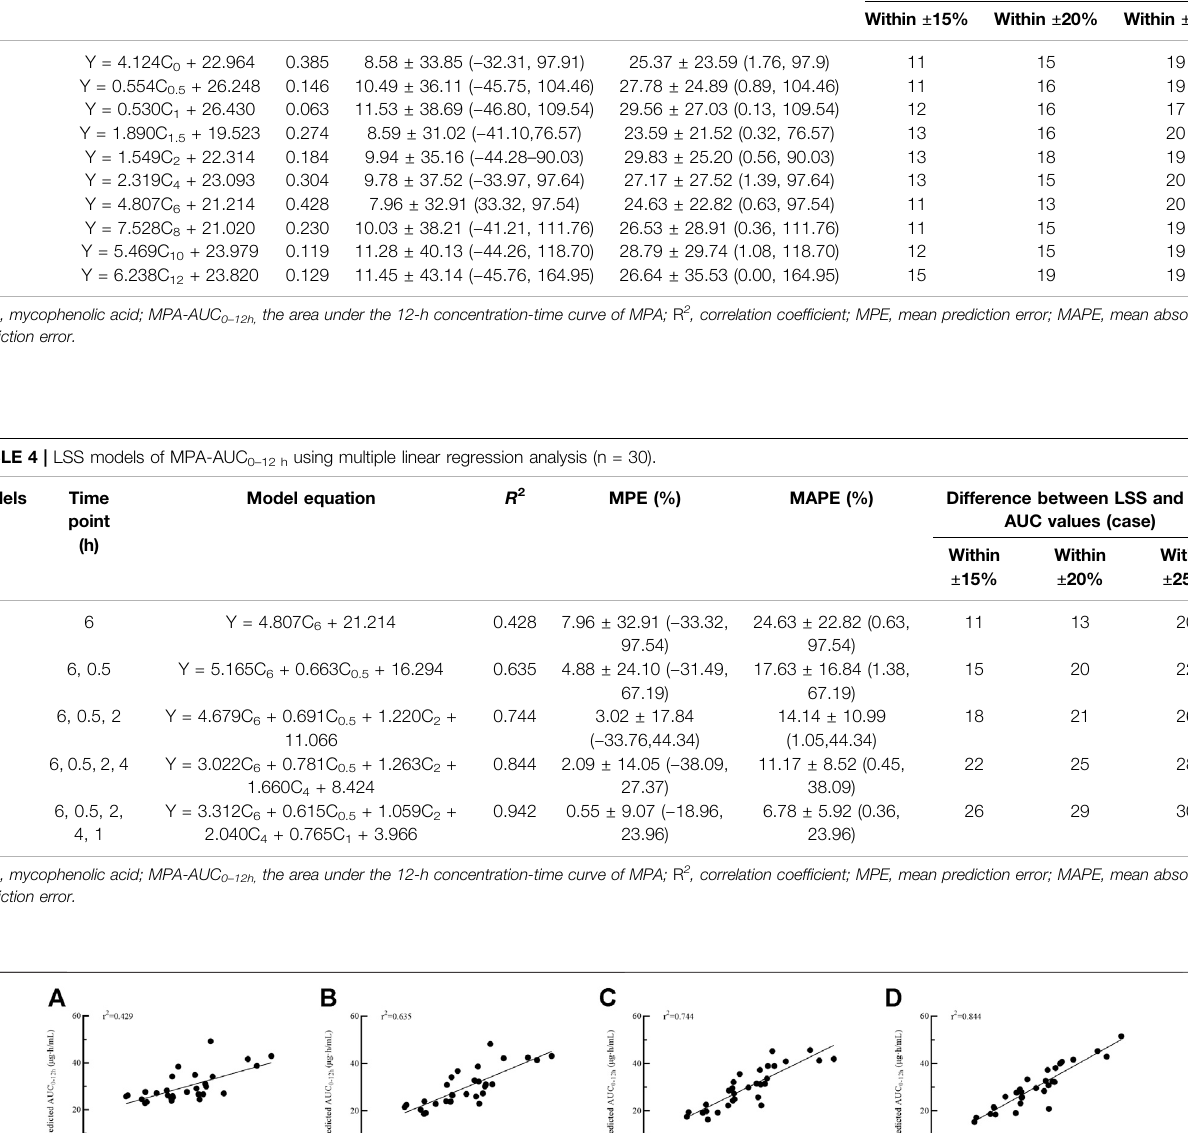
Frontiers in Pharmacology |